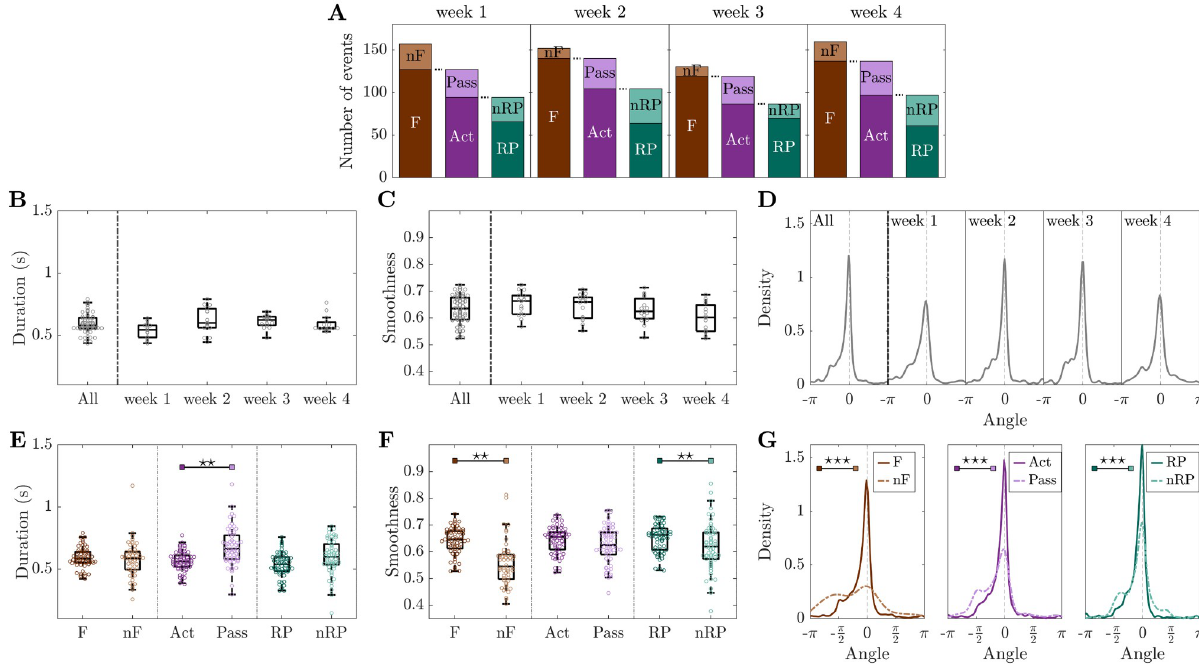
Fig 4. Cortical propagation features discriminate event types in healthy mice. (A) Mean number of events per mouse per week, partitioned by type of event. (B-D) Duration, smoothness, and angles distribution are preserved over weeks. (E) Event duration is a marker for discriminating active (Act) and passive (Pass) events. (F) Smoothness discriminates force (F) and non-force (nF) events, as well as reward pulling (RP) and non-reward pulling (nRP) events. (G) Narrowing down the type of event leads to more directed propagation patterns.—Duration and angle are weighted by smoothness. Markers in (B,C,E,F) refer to the average value per day. In (B,C) each point is the average of all events per day per mouse, while in (E,F) each point is the average of all events of a specific type per day per mouse. Within each box in (B-F), the central mark indicates the median, and the bottom and top edges of the box indicate the 25 th and 75 th percentiles, respectively. Control group n = 3 mice. P-values of statistical tests in S1 Table, “ ? ” refers to difference in